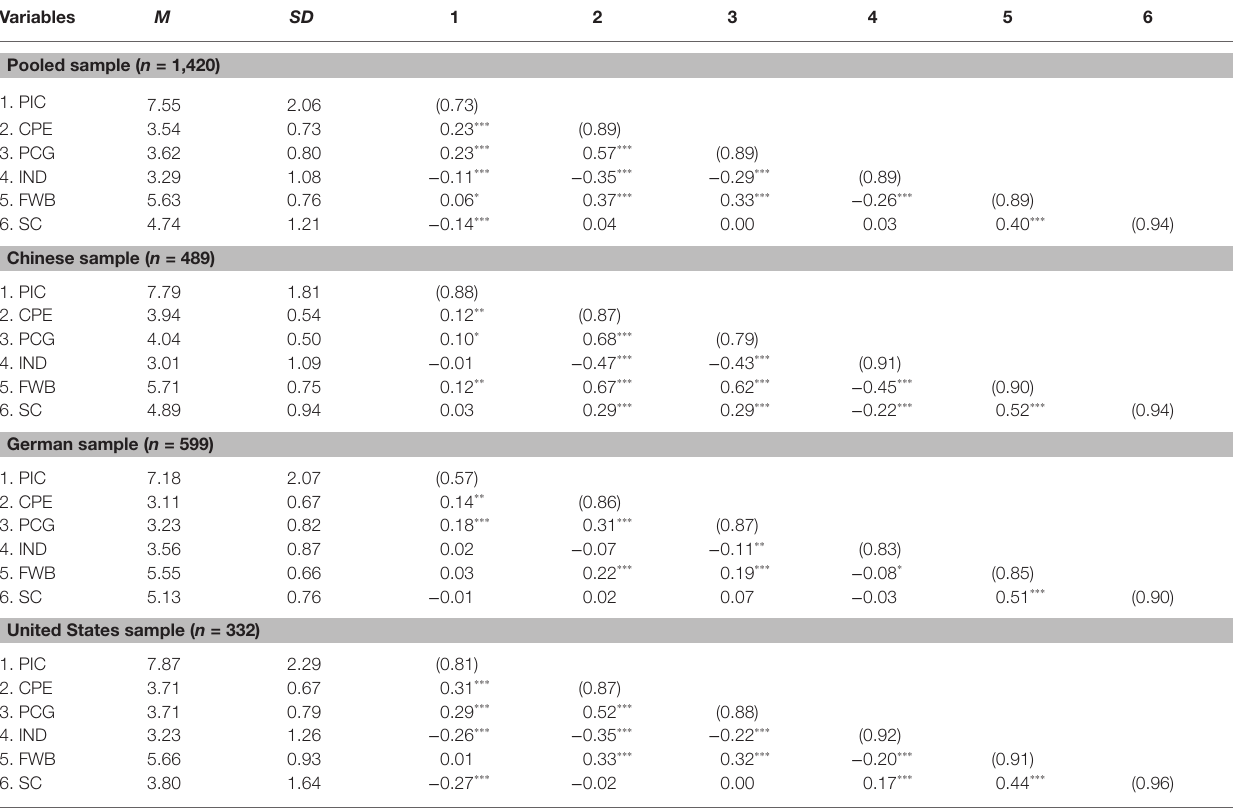
TABLE 4 | Descriptive statistics, correlations, and reliability of variables.